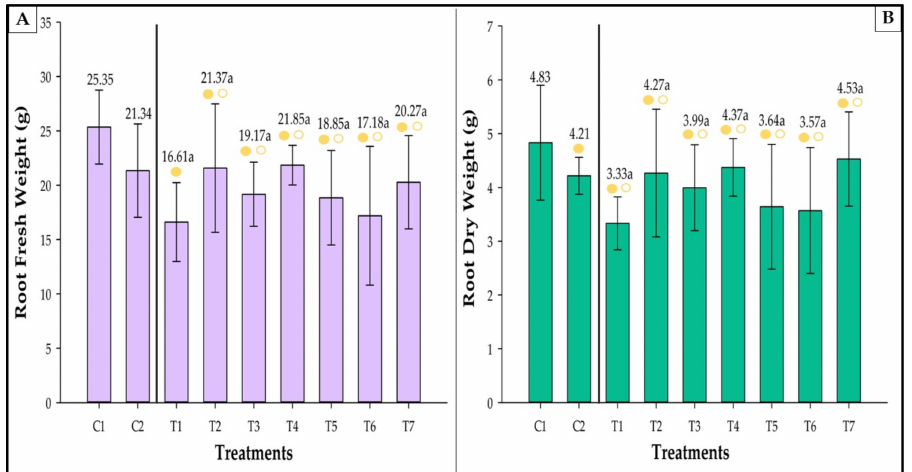
Figure 8. Root fresh ( A ) and dry ( B ) weights of strawberries inoculated with Azospirillum brasilense , Bacillus megaterium , and Brevibacillus fluminis , alone and in mixtures. Closed ( indicate comparisons withs Controls 1 and 2, respectively. Yellow circles indicate that the values are equivalent to those observed in the controls according to Dunnet’s test ( p ≤ 0.05). Means followed by the same letter do not differ statistically according to Duncan’s test ( p ≤ 0.05). C1: control without inoculation + fertilization 100% of N and P; C2: control without inoculation + fertilization 30% of N and P; T1 : Azospirillum brasilense (Ab-v5); T2: Bacillus megaterium (0004); T3: Brevibacillus fluminis (MET12M2); T4: Ab-v5 + 0004; T5: Ab-v5 + MET12M2; T6: 0004 + MET12M2; T7: Ab-v5 + 0004 +